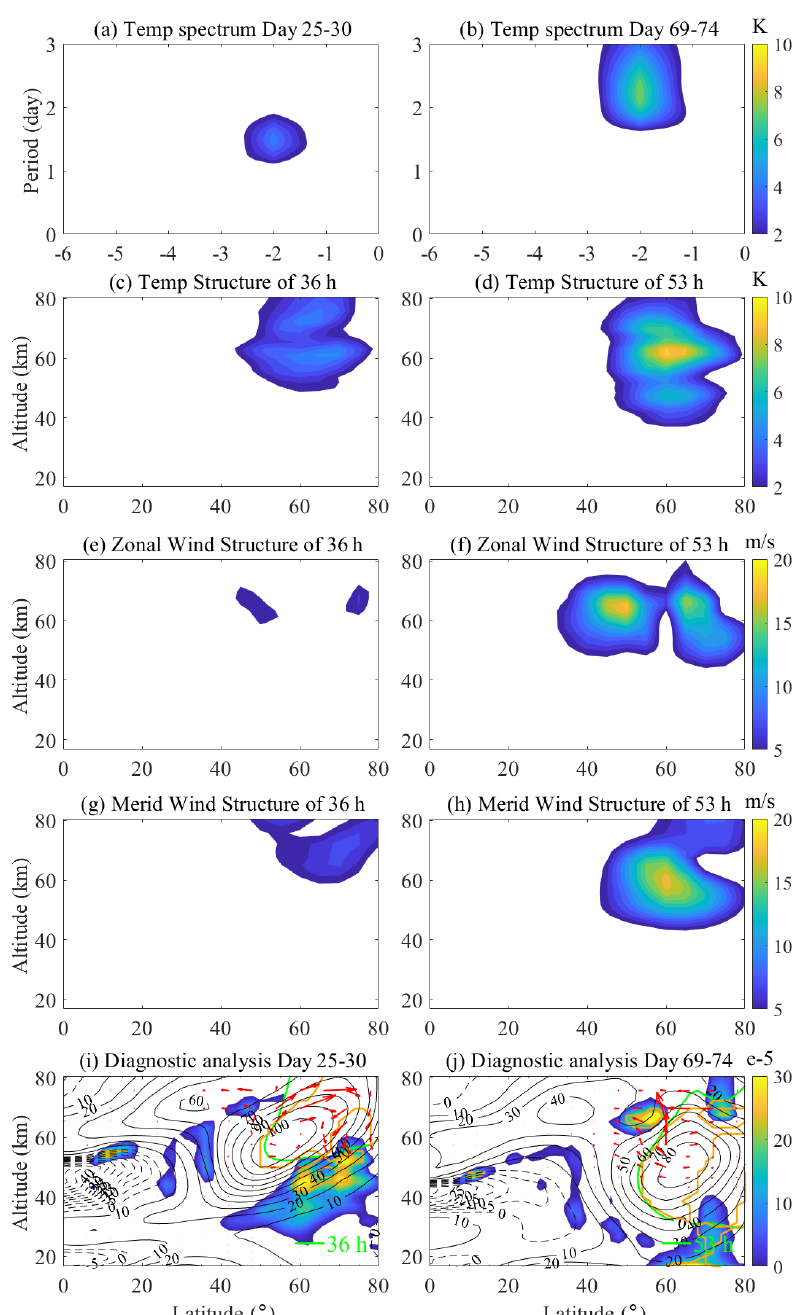
Figure 10. Same as Fig. 9 but for E2 during the 2019 boreal winter period.